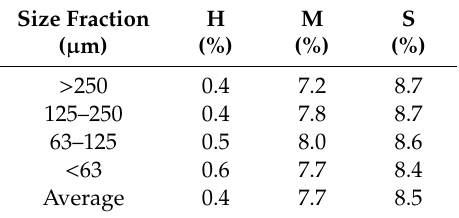
Table 6. Cu-metal content of the different size fractions and average value of the samples H, M, and S.